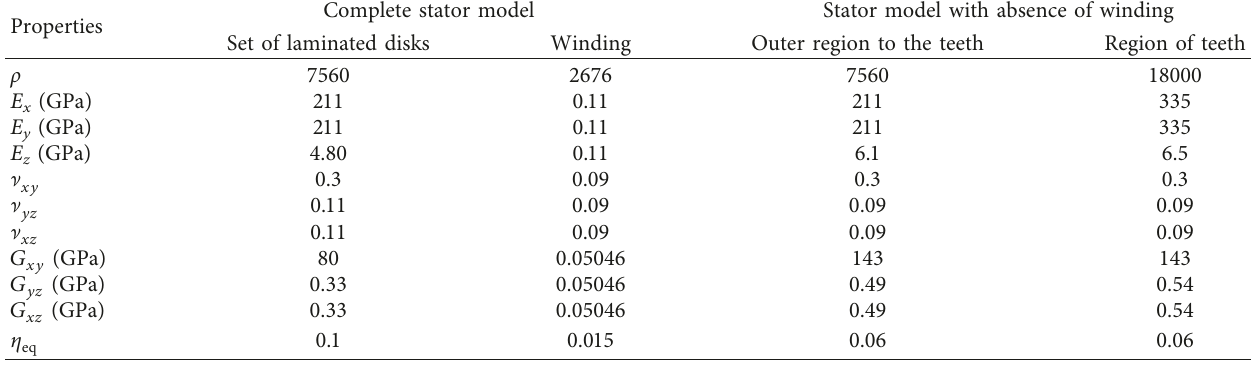
Table 5: Orthotropic and isotropic properties adjusted for the equivalent volume of the disks and the winding, for the complete model. Orthotropic properties adjusted for the equivalent volume of the disks for the stator model with absence of winding (0 to 10kHz). Properties